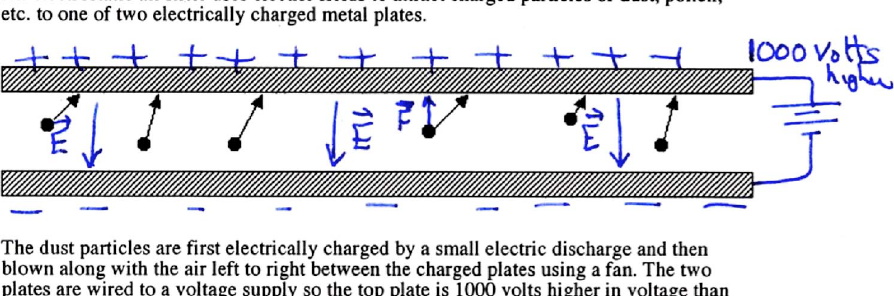
FIG. 3. (cid:1) Color (cid:2) Example exam problem (cid:1) and instructor solution (cid:2) with pictorial, mathematical, and verbal components. The problem is from a reform 202 exam.